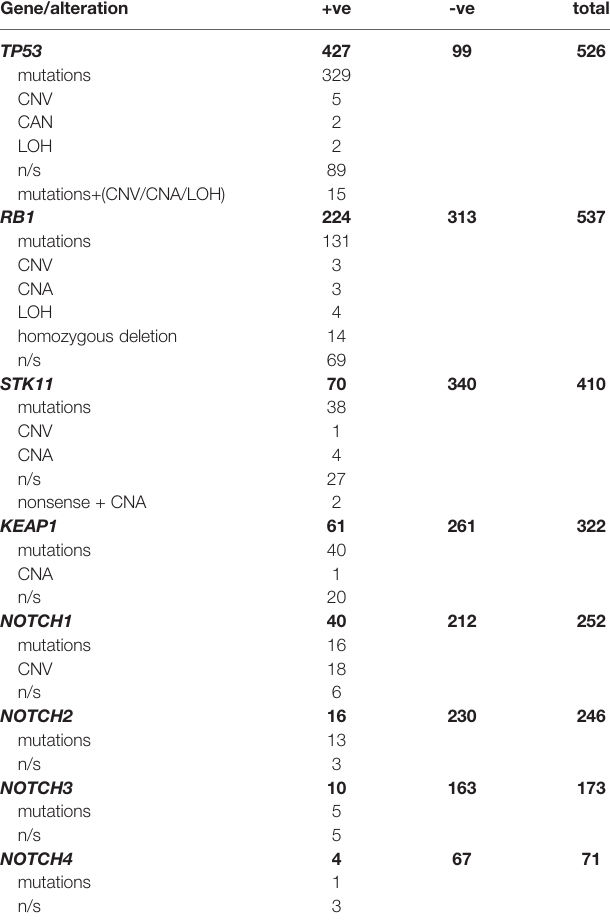
TABLE 3 | FrequencyofgenealterationsassociatedwithLCNEC